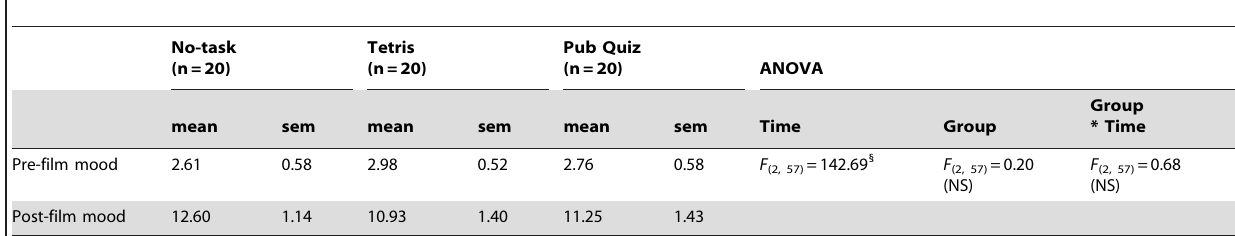
Table 2. Experiment 1 means and statistics for mood assessment (pre vs. post-trauma film) indicating equivalent deterioration in mood over the film across conditions.